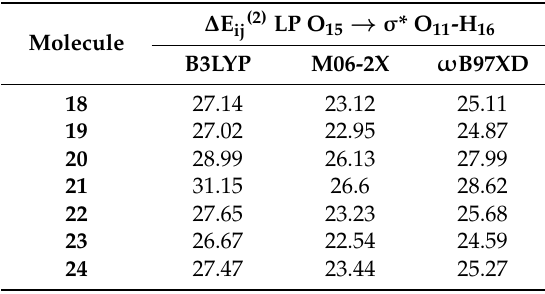
Table 3. Second order stabilization energies (ΔE ij(2) ) between donor LP O 15 and acceptor σ* O 11 -H 16 orbitals involved in the IMHB. Energies in kcal/mol.